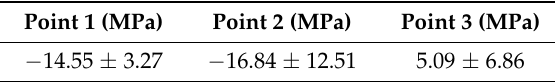
Figure 3. Layout of measurement points. Table 1. Residual stress measured by X-ray.